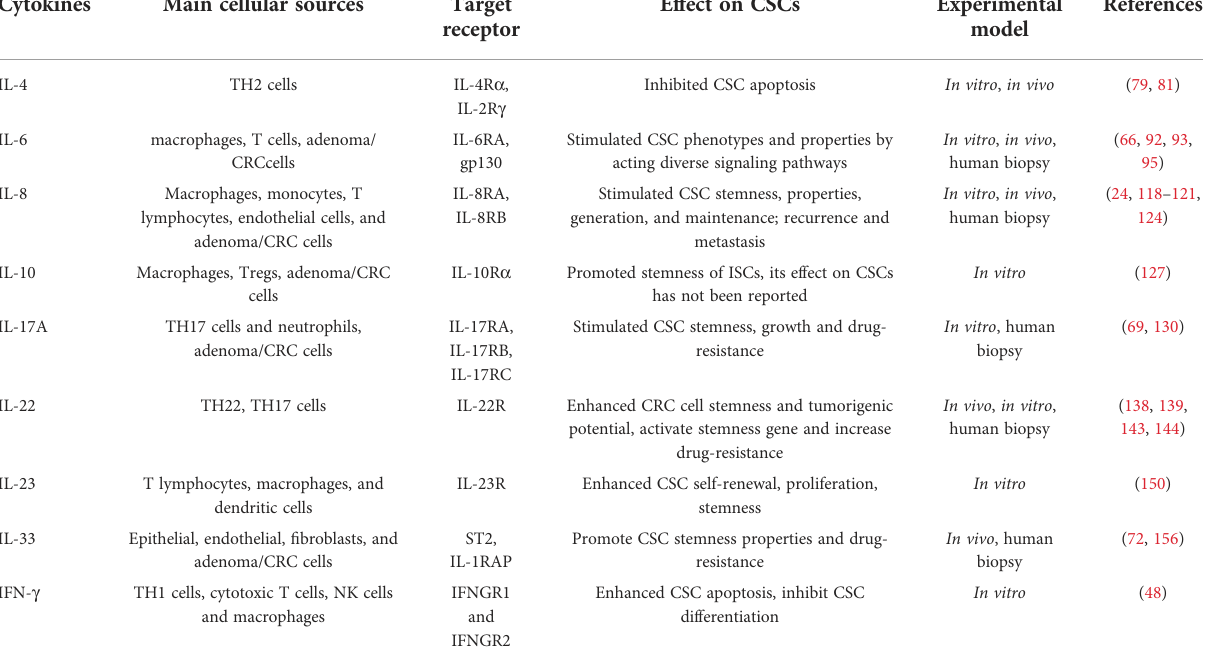
TABLE 1 Main cytokines known to modulate CRC CSCs.